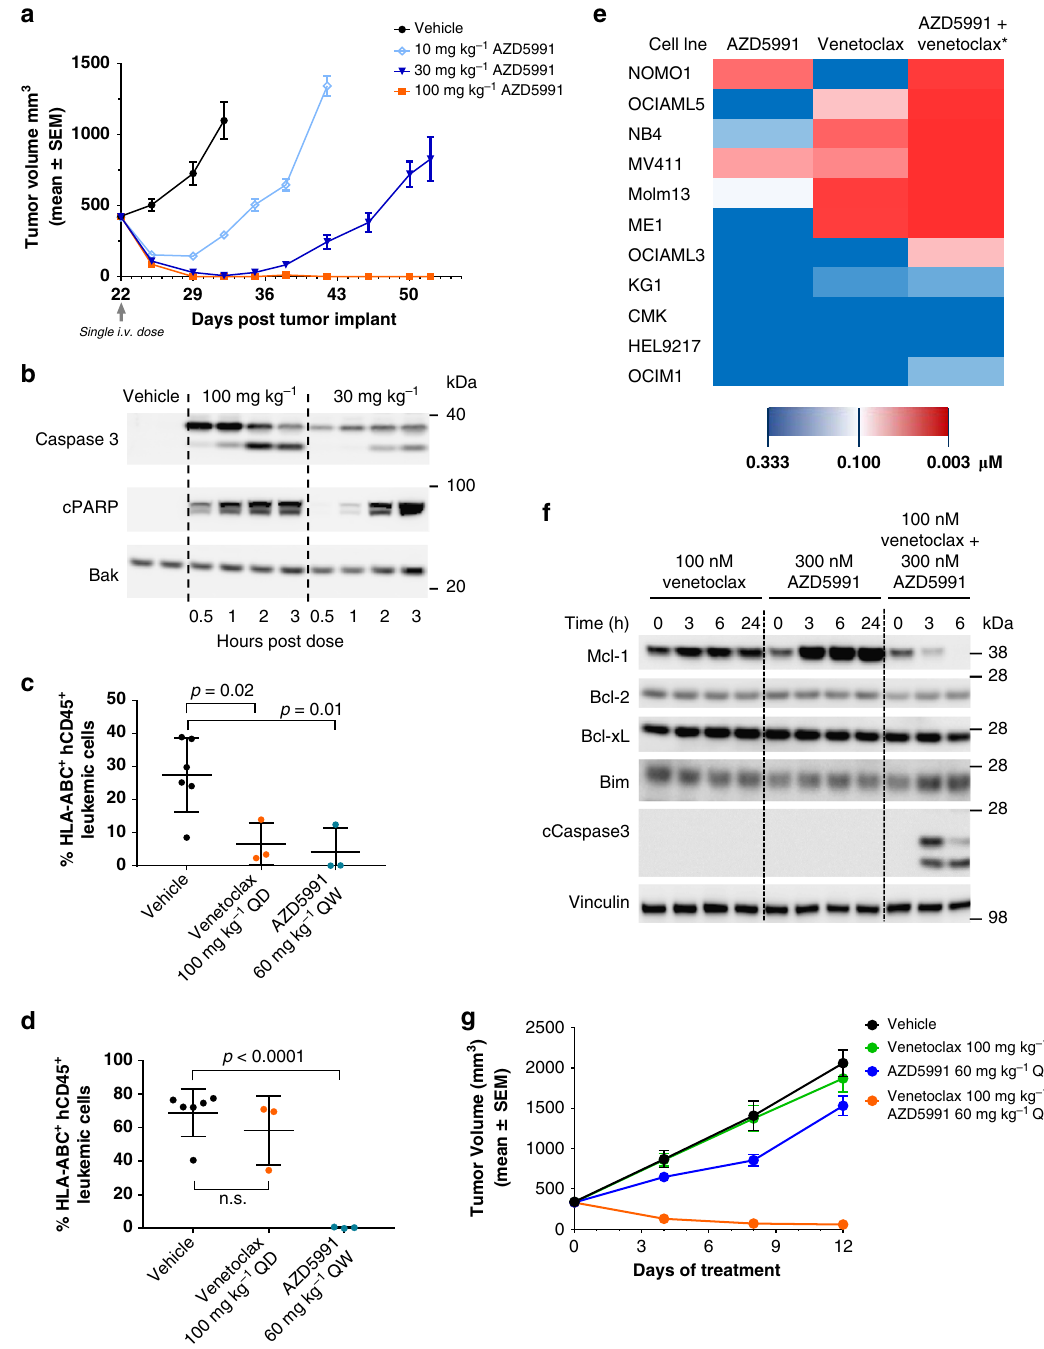
Fig. 7 AZD5991 causes tumor regression in AML models. a Subcutaneous tumor growth in the MV4-11 tumor model treated with a single i.v. dose of AZD5991 at 10, 30, or 100 mg kg − 1 . Values are presented at mean ± SEM, six mice were tested per group. b MV4-11 tumor lysates prepared from mice dosed with a single i.v. dose of AZD5991 at 30 mg kg − 1 ( n = 4), 100 mg kg − 1 ( n = 4), or vehicle control ( n = 2) were evaluated for expression of caspase 3 and cleaved PARP by western blotting. Leukemic cells (HLA-ABC + hCD45 + ) were assessed by fl ow cytometry in peripheral blood ( c ) or bone marrow ( d ) obtained from mice engrafted with MOLM-13 leukemia cells and treated with vehicle ( n = 6), venetoclax at 100 mg kg − 1 per oral daily ( n = 3) or AZD5991 at 100 mg kg − 1 i.v. once weekly ( n = 3). Analysis were performed on day 10 after treatment initiation. A non-parametric, unpaired, two-tailed t